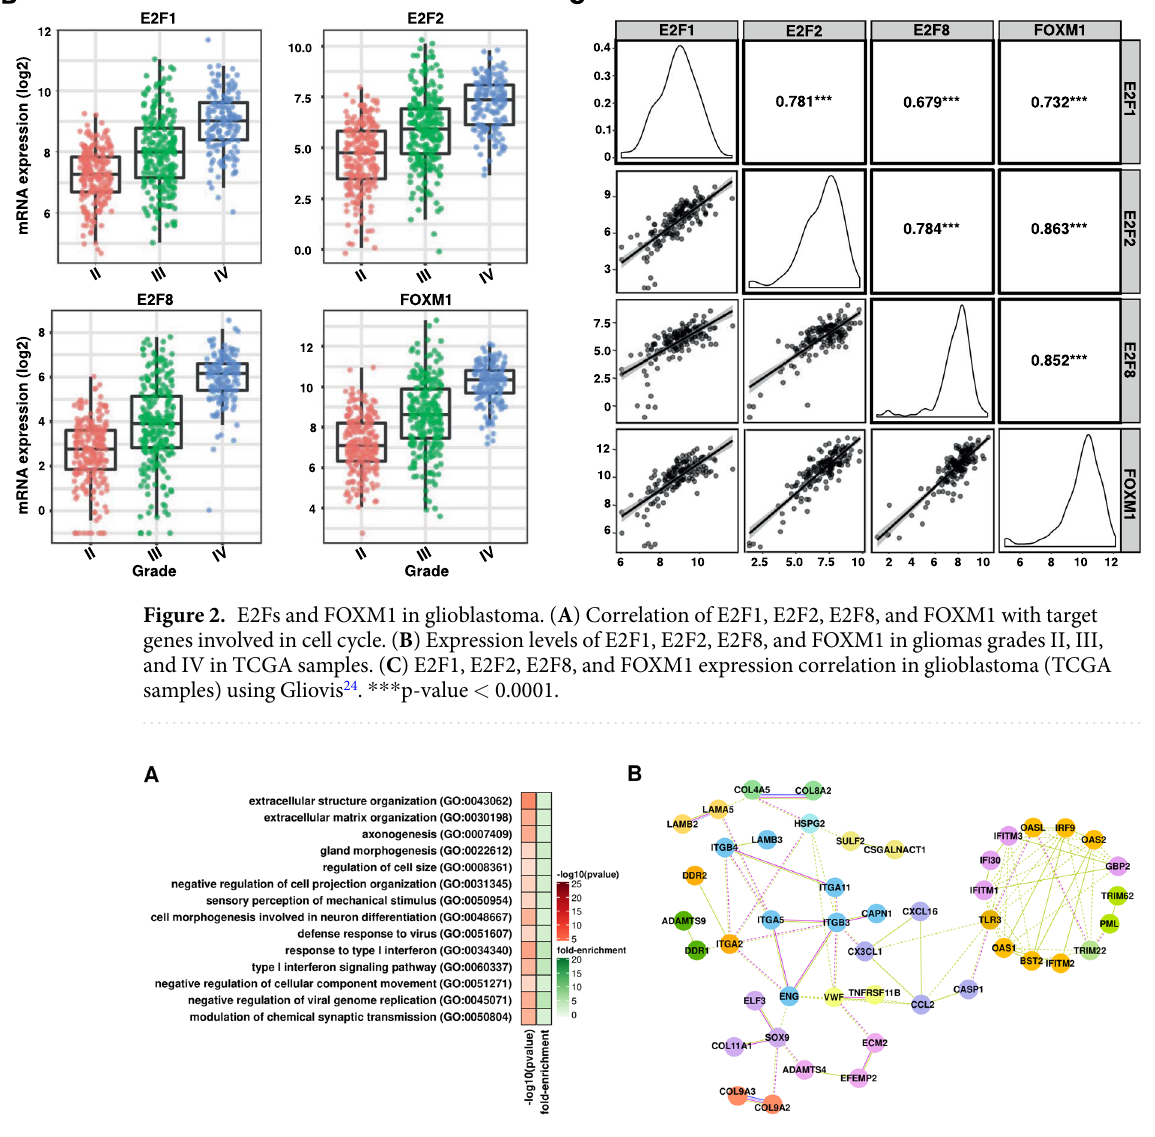
Figure 3. Global view of upregulated genes at T24 post-radiation in glioblastoma cells. ( A ) Gene ontology analysis of upregulated genes ( B ) Protein-protein interaction networks according to STRING 99 showing genes associated with extracellular matrix organization and response to interferon. Gene clusters based on the strength of connection and gene function are identified by color. Lines colors indicate type of association: light green, association based on literature findings; blue indicates gene co-occurrence; magenta indicates experimental